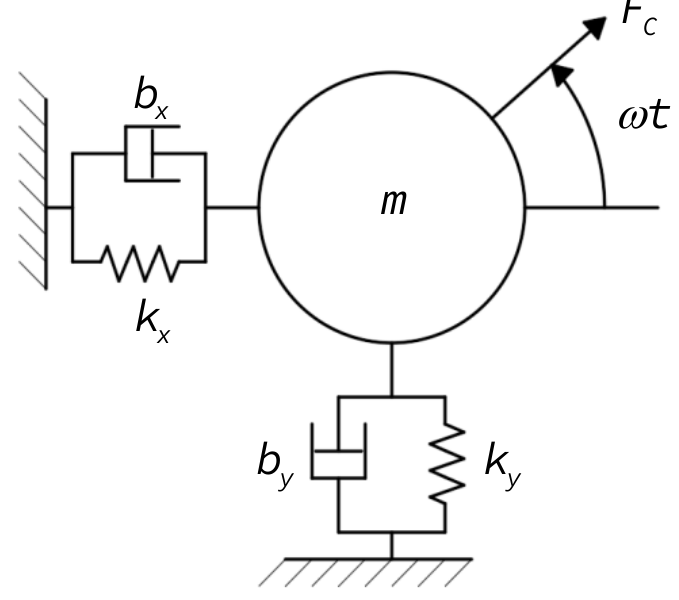
Figure 6. Model with dampers and springs.